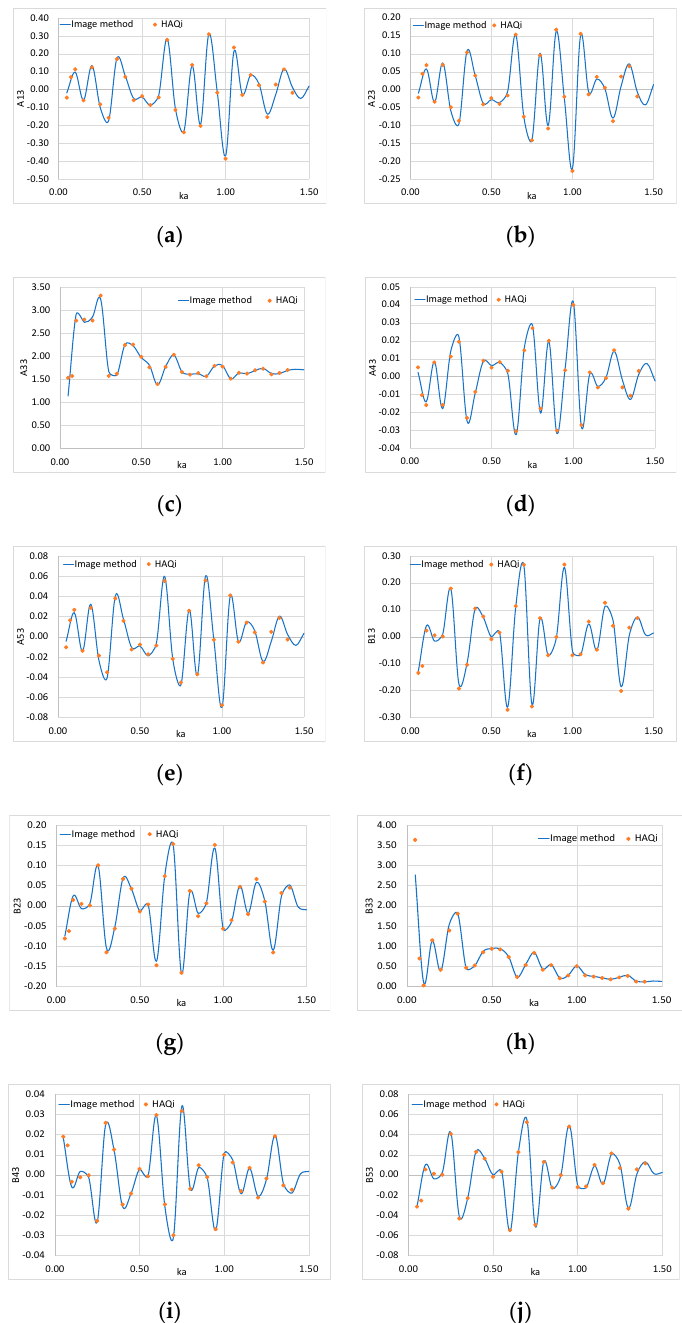
Figure 4. Hydrodynamic coefficients of the converter placed in front of a 60-degree V-shaped breakwater. The results of the method of images are compared with the corresponding ones from an analytical formulation assuming a finite length breakwater: ( a ) added mass in surge due to WEC’s (wave energy converter) motion in heave; ( b ) added mass in sway due to WEC’s motion in heave; ( c ) added mass in heave due to WEC’s motion in heave; ( d ) added mass in roll due to WEC’s motion in heave; ( e ) added mass in pitch due to WEC’s (wave energy converter) motion in heave; ( f ) damping coefficient in surge due to WEC’s (wave energy converter) motion in heave; ( g ) damping coefficient in sway due to WEC’s (wave energy converter) motion in heave; ( h ) damping coefficient in heave due to WEC’s (wave energy converter) motion in heave; ( i ) damping coefficient in roll due to WEC’s (wave energy converter) motion in heave; ( j ) damping coefficient in pitch due to WEC’s (wave energy converter) motion in heave.